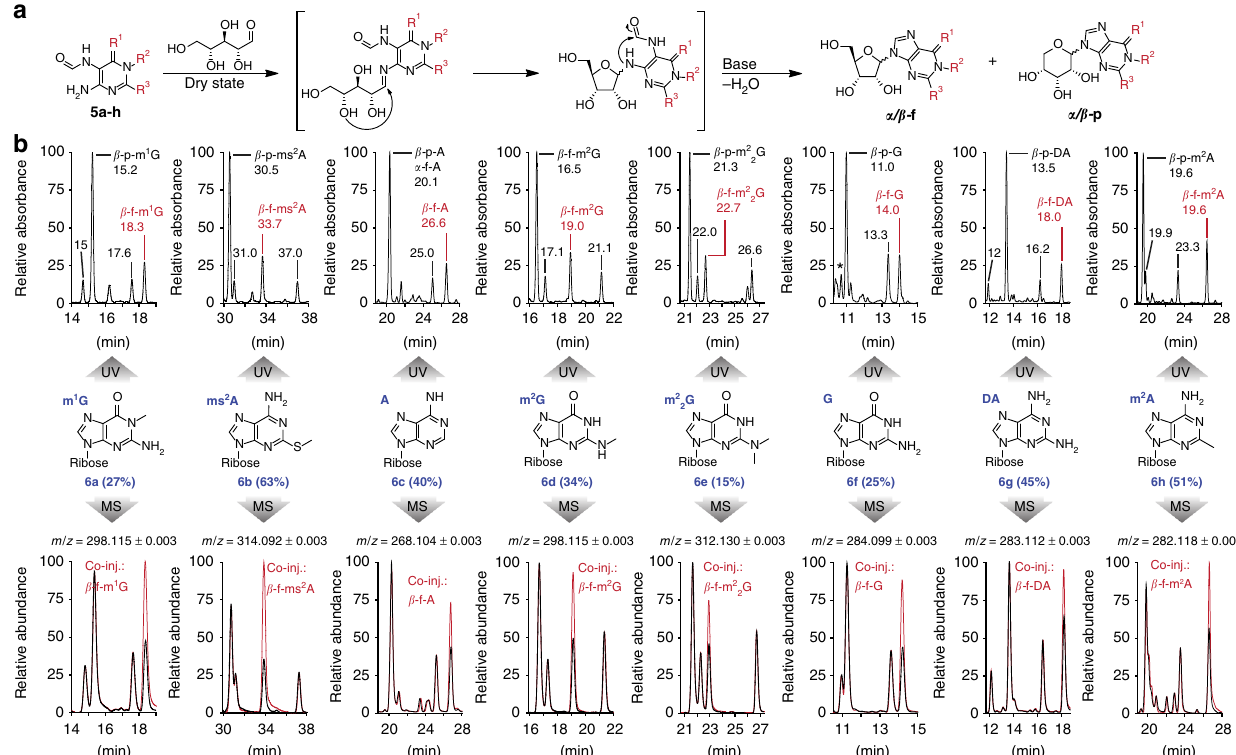
Fig. 4 Formation of RNA nucleosides from nucleobase precursors. a Reaction mechanism for the formation of canonical and non-canonical RNA nucleosides 6a-h from formamidopyrimidines (FaPys) 5a-h and ribose. The reaction provides the four expected isomers α / β ribopyranosides ( α / β − p) and α / β – ribofuranosides ( α / β − f). b LC-MS analysis of the reaction products from 5a-h and ribose. Compounds identi fi ed by MS detection are labeled ( β − p or α / β − f). The UV- and MS-chromatograms show all four expected isomers for each compound (labeled with the retention time or asterisk (*) in the UV- chromatogram). The structural assignment was assisted by co-injection (Co-inj.) studies. The MS traces show in red the co-injection signal obtained with the naturally occurring isomer ( β −